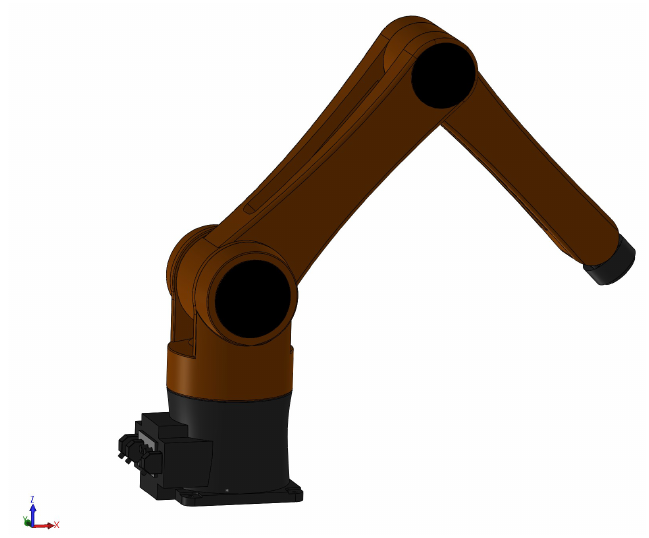
Figure 3. Geometric representation of the robot model. Table 2. Basic design parameters of a 3-DOF robot system.